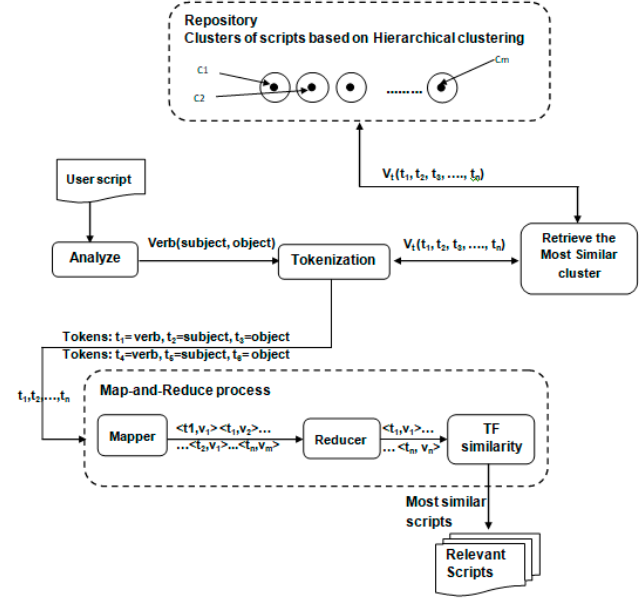
Figure 4. H-clustering-map-and-reduce retrieval process.